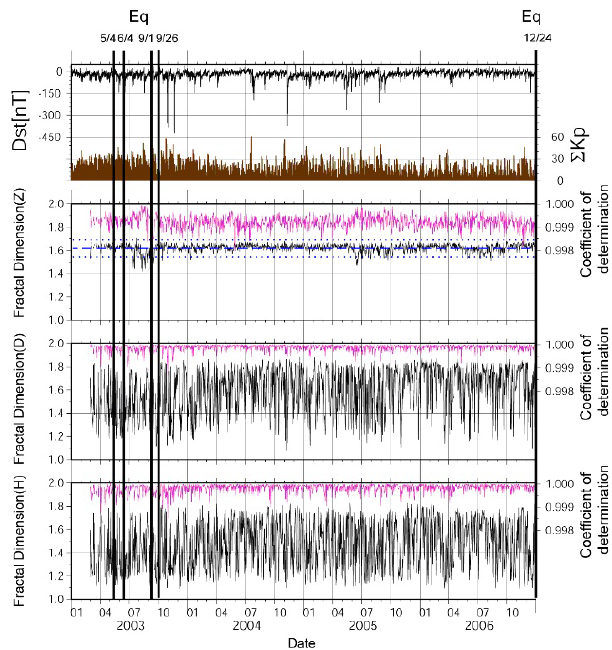
Fig. 2. Temporal evolutions of (top) geomagnetic activity (upper is Dst (nT ) and the lower, 6K p ) and (bottom) fractal dimension (upper) and the coefficient of determination in fractal dimension analysis (lower). The data are from March 2003 to end of Octo- ber of 2006, and the date of EQ is 1 September 2003. Horizontal blue broken line is the average value of fractal dimension during the whole period, while the upper and lower blue dotted lines mean ± 2 σ ( σ : standard deviation)